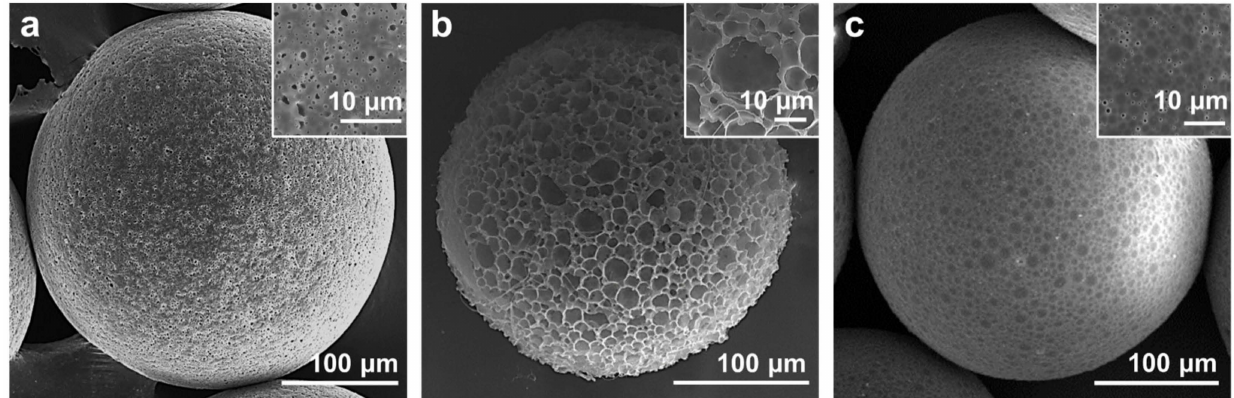
Figure 5. ( a – c ) Typical microspheres with different pore size and